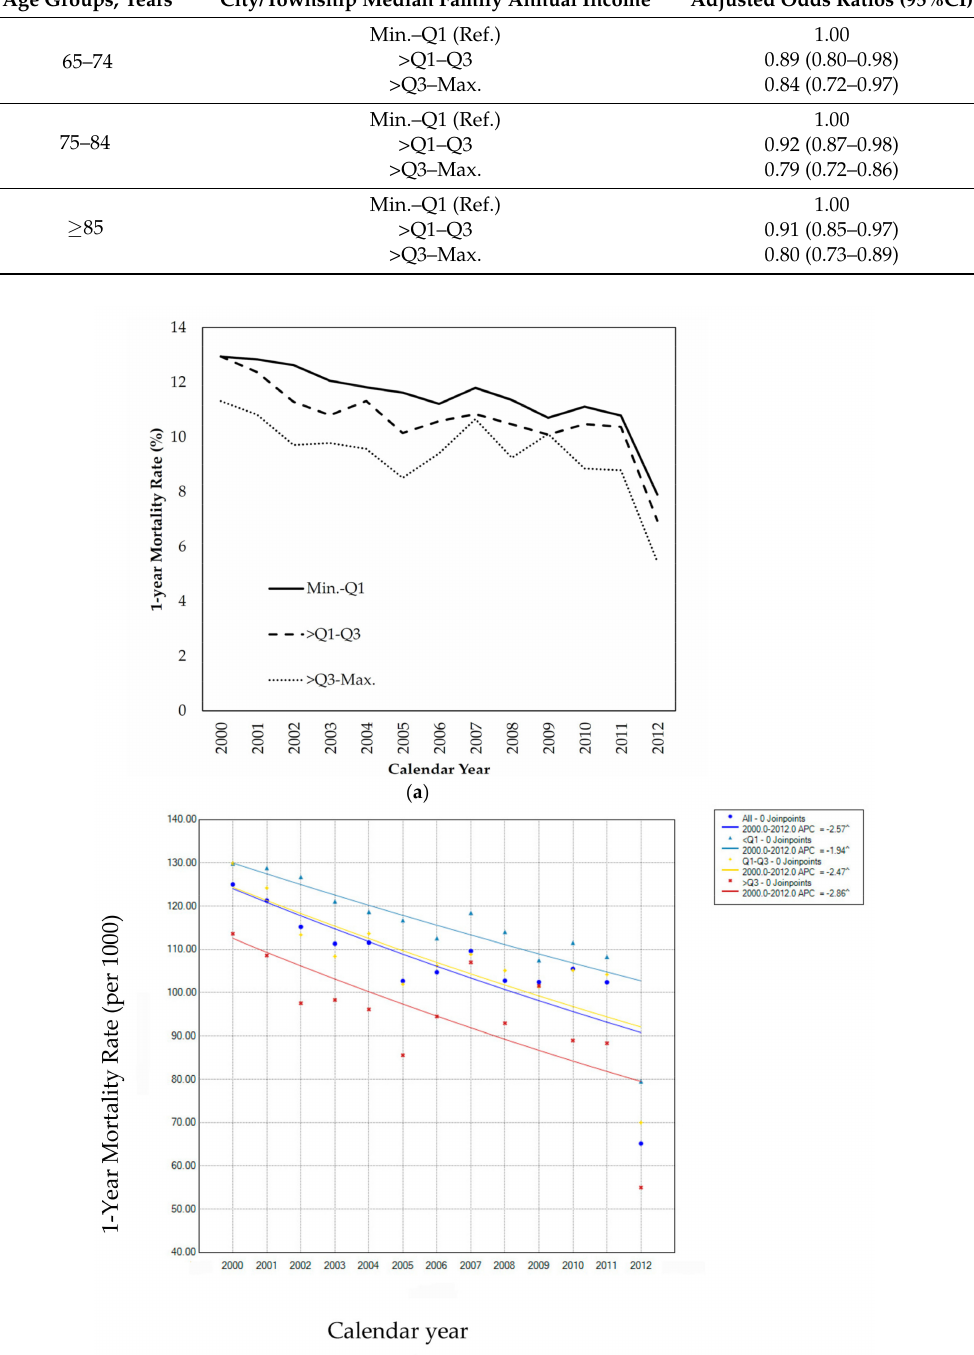
Table 3. Odds ratios of one-year mortality in relation to median family annual income levels according to a patient’s age.